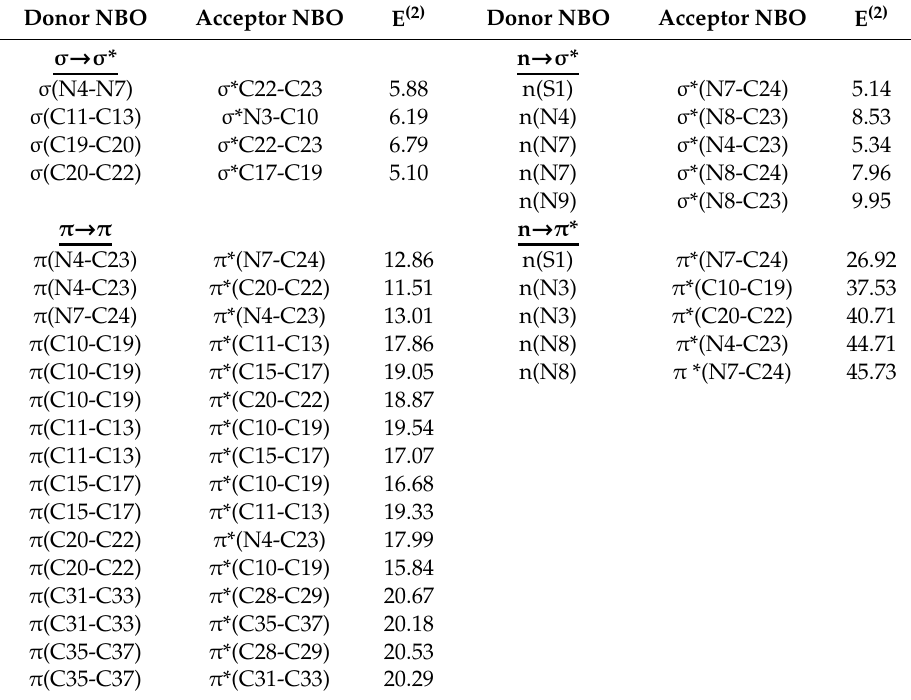
Table 6. The E (2) (kcal / mol) values for the intramolecular charge transfer interactions in 2 a .